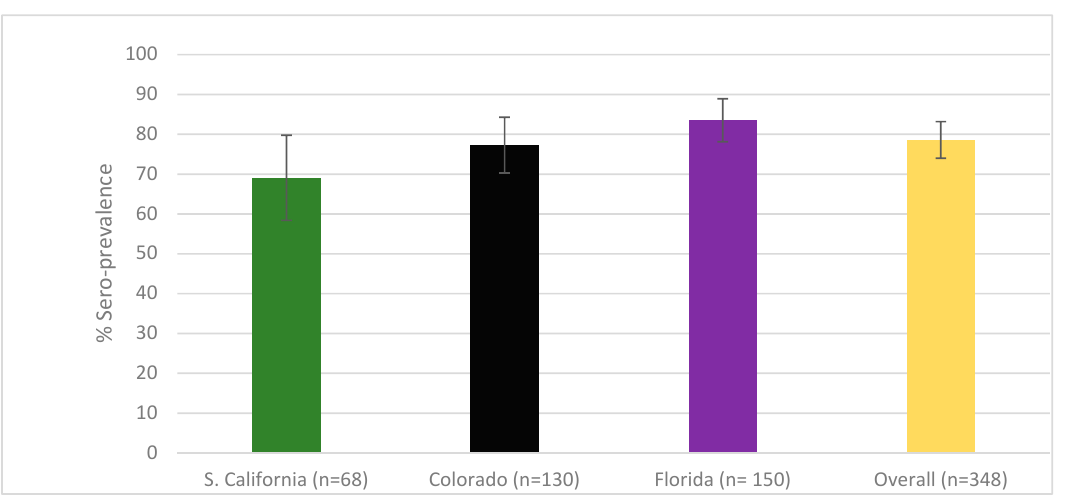
Figure 1. Puma feline foamy virus was found in high sero-prevalence in the U.S. Sero-prevalence by state: Southern California 69.1% (95% CI: 56.7, 79.8%); Colorado 77.3% (95% CI: 69.1, 84.3%); Florida 83.5% (95% CI: 77.0, 88.9%). Sero-prevalence across all sampling locations (overall) was 78.6% (95% CI: 74.0, 82.7%). There was no significant difference between states ( p = 0.14).